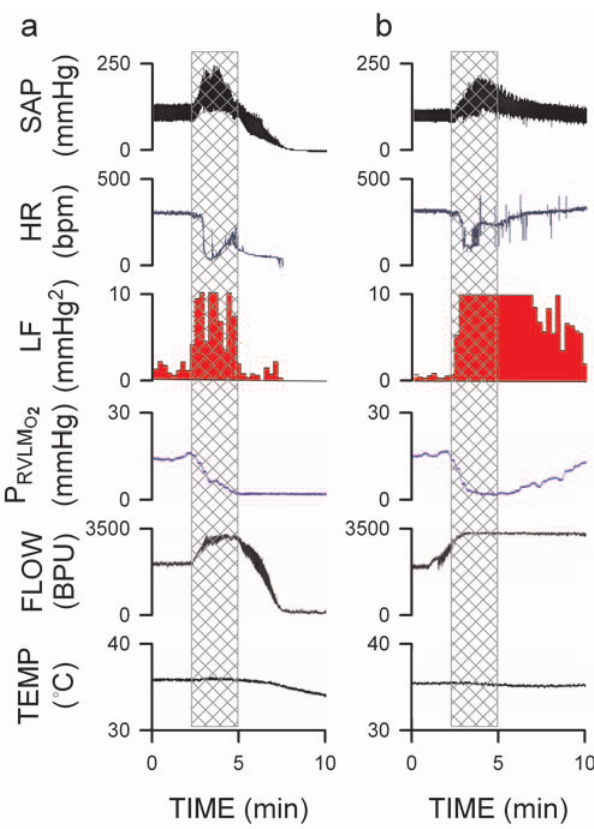
Figure 1. Loss of functional integrity of rostral ventrolateral medulla (RVLM) because of anoxia prevents resumption of spontaneous circulation after cardiac arrest. Representative continuous tracings showing temporal changes in systemic arterial pressure (SAP), heart rate (HR), power density of low-frequency (LF) component of SAP spectrum as an experimental index for functional integrity of RVLM and prevalence of the ‘‘life-and-death’’ signal, and tissue oxygen concentration, microvascular perfusion or temperature in RVLM of rats that died of (a) or resumed spontaneous circulation after (b) cardiac arrest induced by intravenous administration of mevinphos (Mev; 1000 m g/kg; at time zero). The vital time-window between cardiac arrest and resumption of spontaneous circulation during which anoxia took place in RVLM is demarcated by crossed bars.